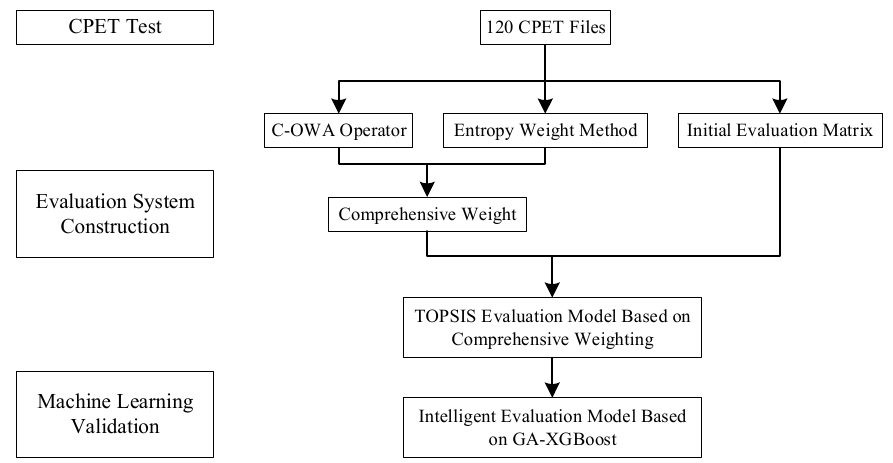
Figure 2. Schema of the study’s design. Table 1. Determination of the weights of subjective and objective indicators.